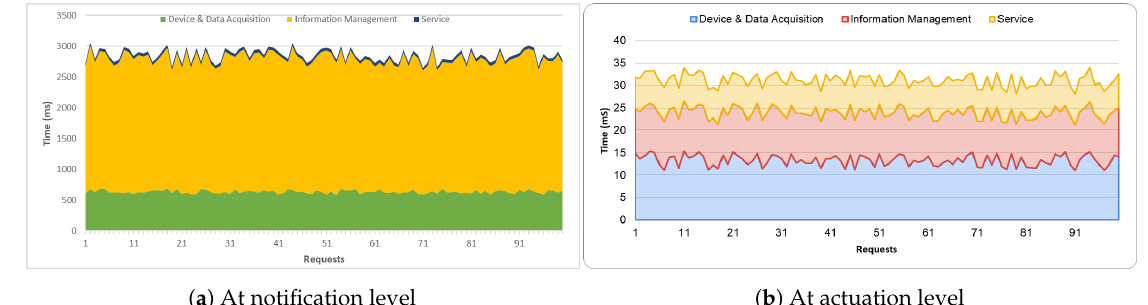
Figure 7. Response time according to the layers that form the platform.